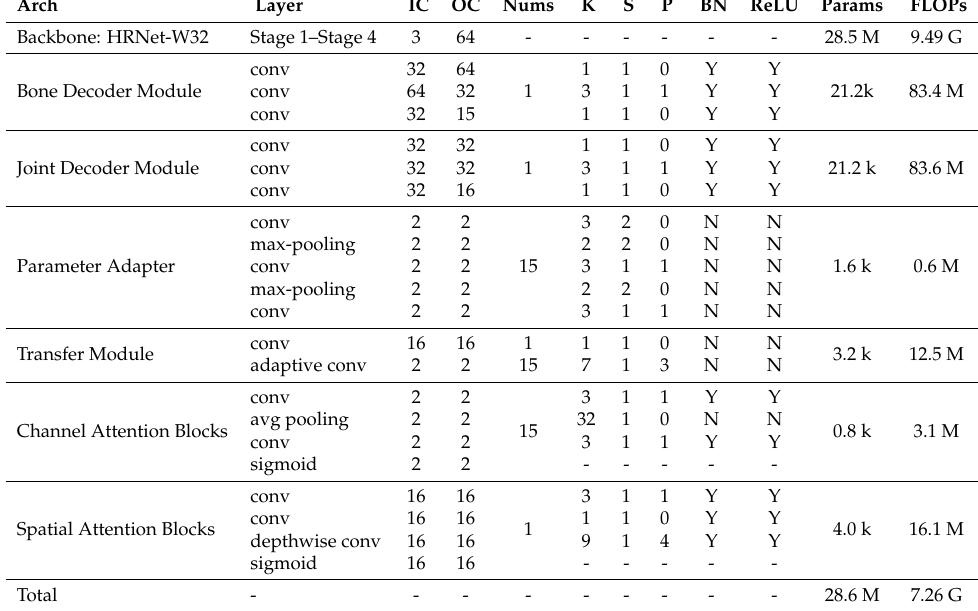
Table 8. Main architectural details of the networks. IC denotes the number of input channels for a layer; OC is the number of output channels; Nums indicates the number of layers; K is the kennel size; S is the stride size; P is the padding size; BN (Y/N) indicates if batch normalization is applied; ReLU (Y/N) indicates if the ReLU activation is used. Arch Layer IC OC Nums Backbone: HRNet-W32